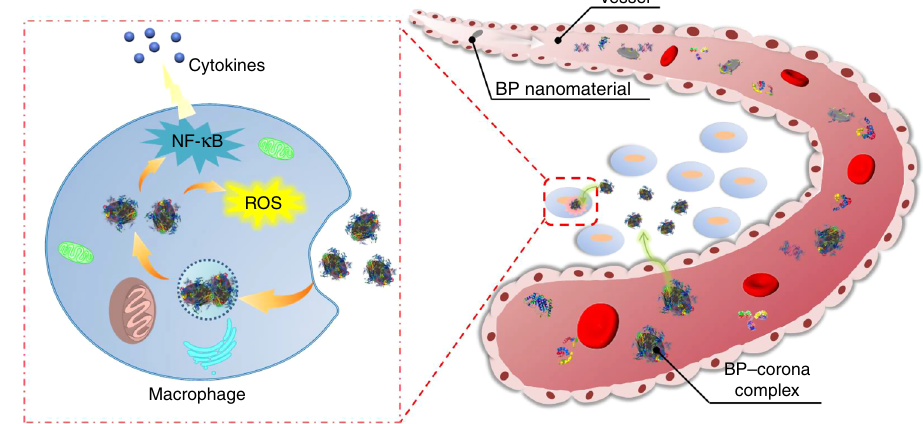
Fig. 1 Summary diagram of immune perturbation of BP – corona complexes. Formation of BP nanomaterial – corona complexes in blood and their immunoregulation on